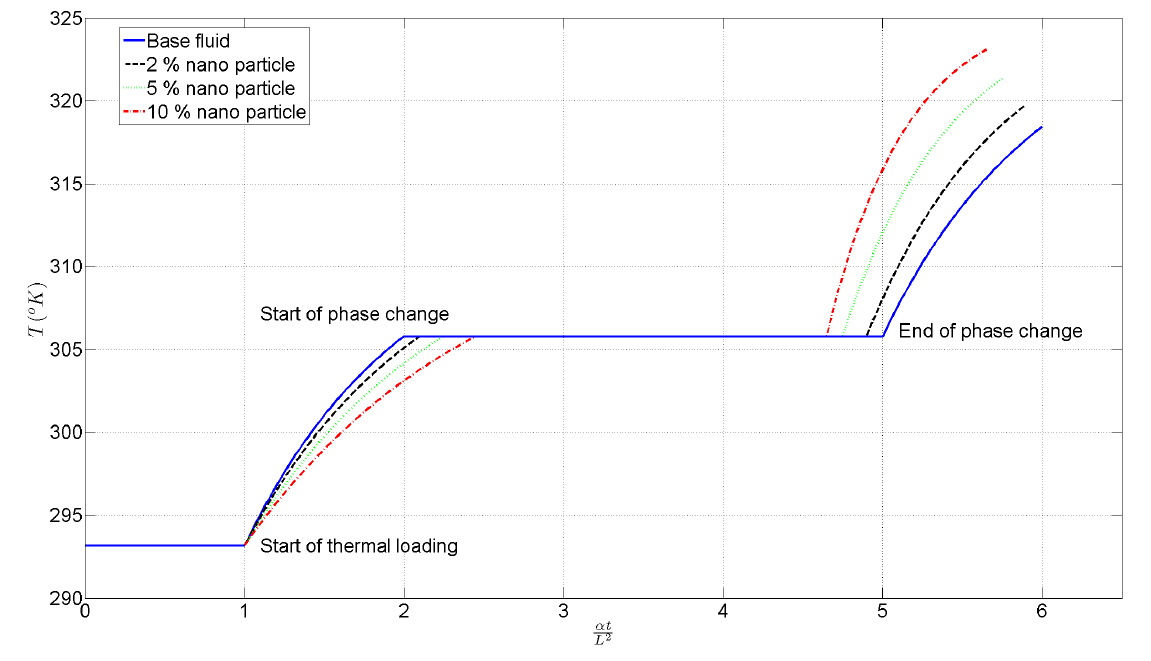
Figure 12. Time dependency of maximum